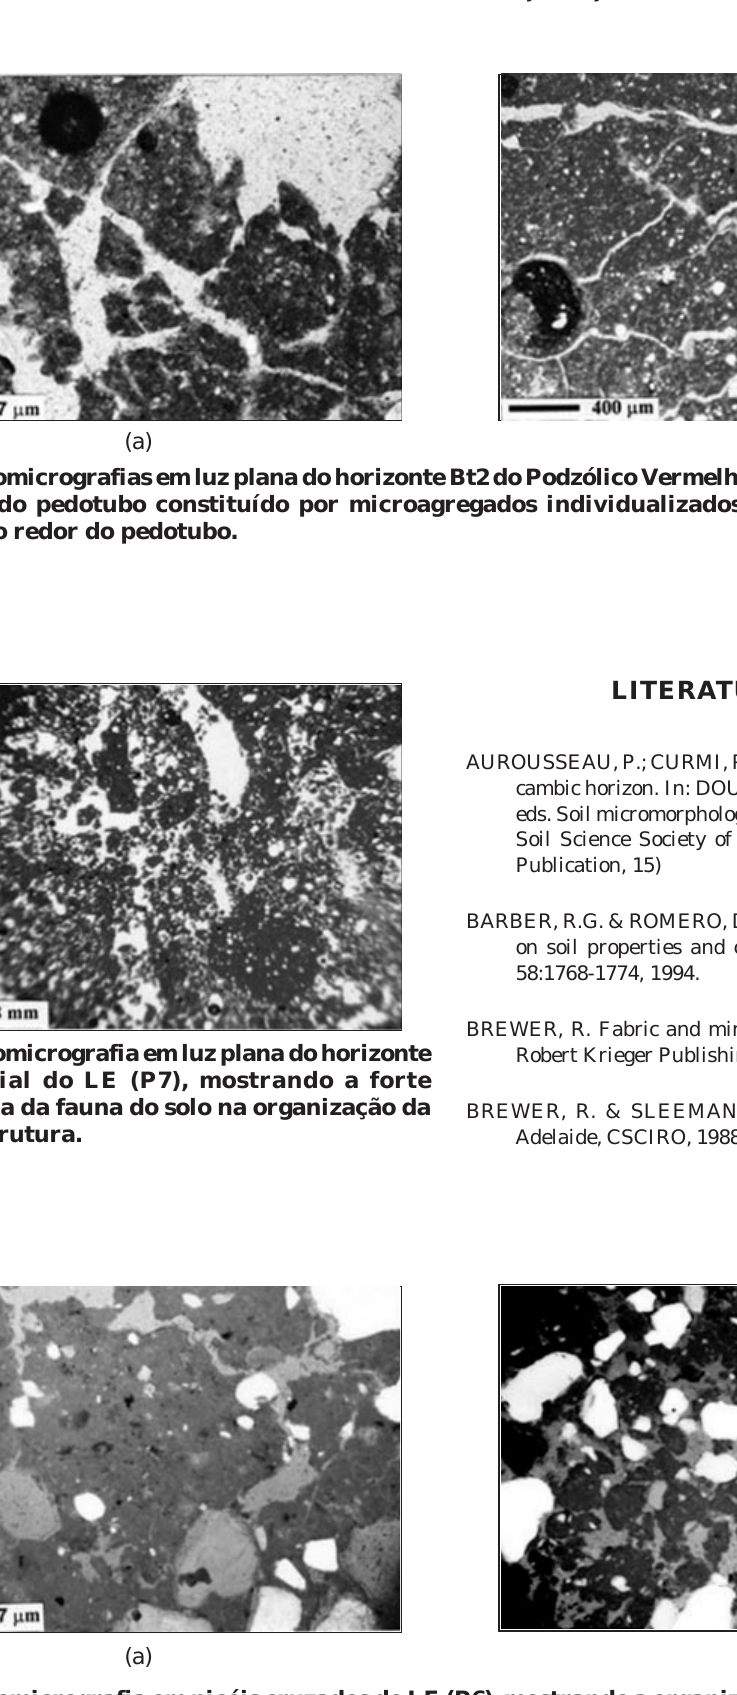
Figura 7. Fotomicrografia em nicóis cruzados do LE (P6), mostrando a organização do plasma: (a) camada compactada; (b) camada não compactada.